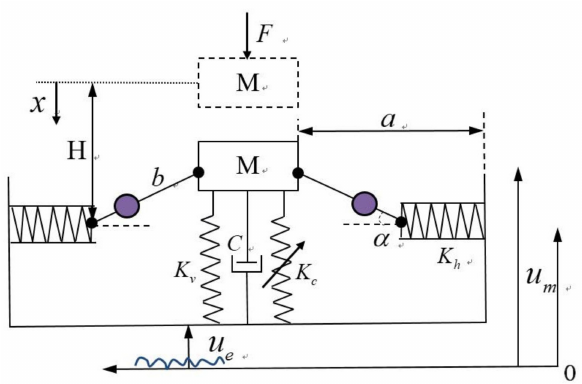
Figure 2. Mathematical model of the seat isolation system with inerter